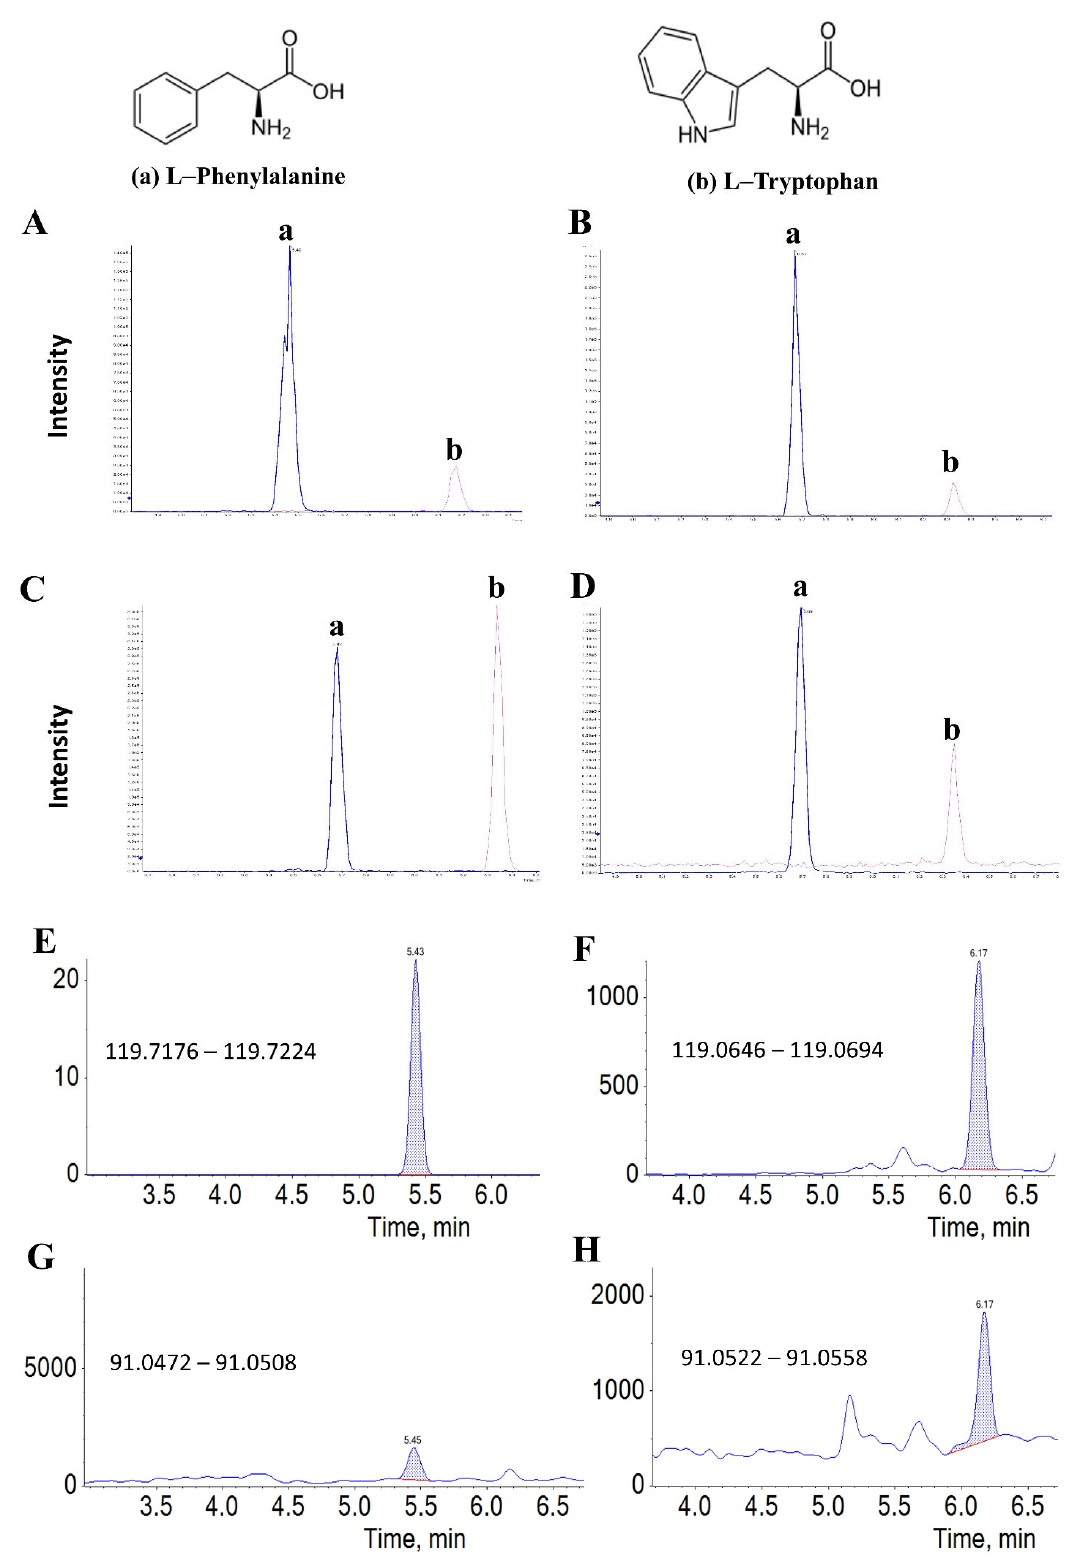
Figure 3. Accuracy of predefined filtration criteria. Two aromatic amino acids, including pheny- lalanine and tryptophan, spiked in ( A ) HL-60 cell extraction ( B ), urine ( C ), and plasma ( D ). Both molecules share a basic aromatic ring structure. The primary identification hitting target depends on the side chain fragmentation ( E , G ) for L -Phenylalanine and ( F , H ) for L